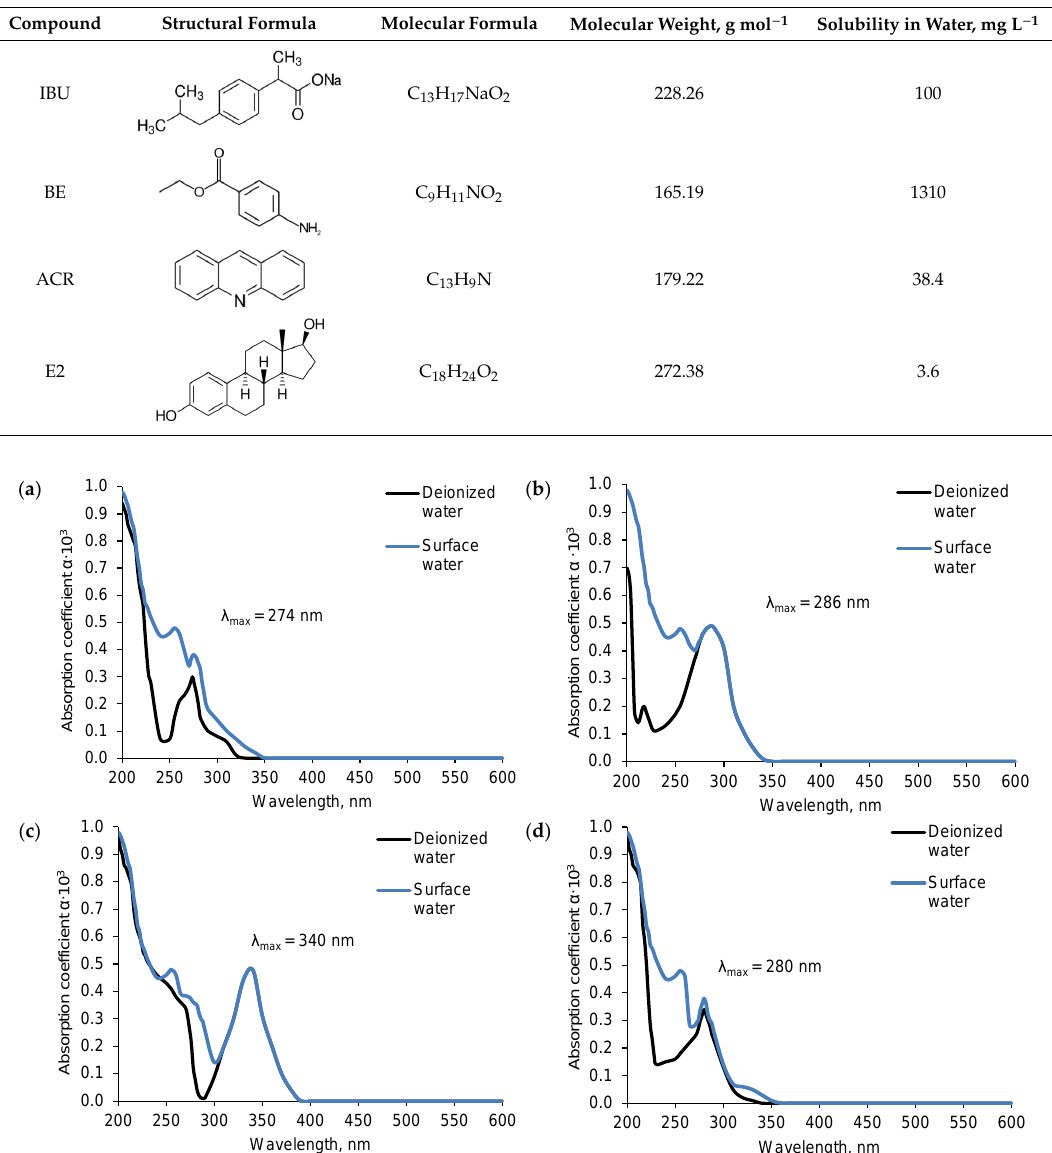
Figure 13. UV-VIS spectrum of ( a ) IBU, ( b ) BE, ( c ) ACR, and ( d ) E2 in deionized and surface water samples.